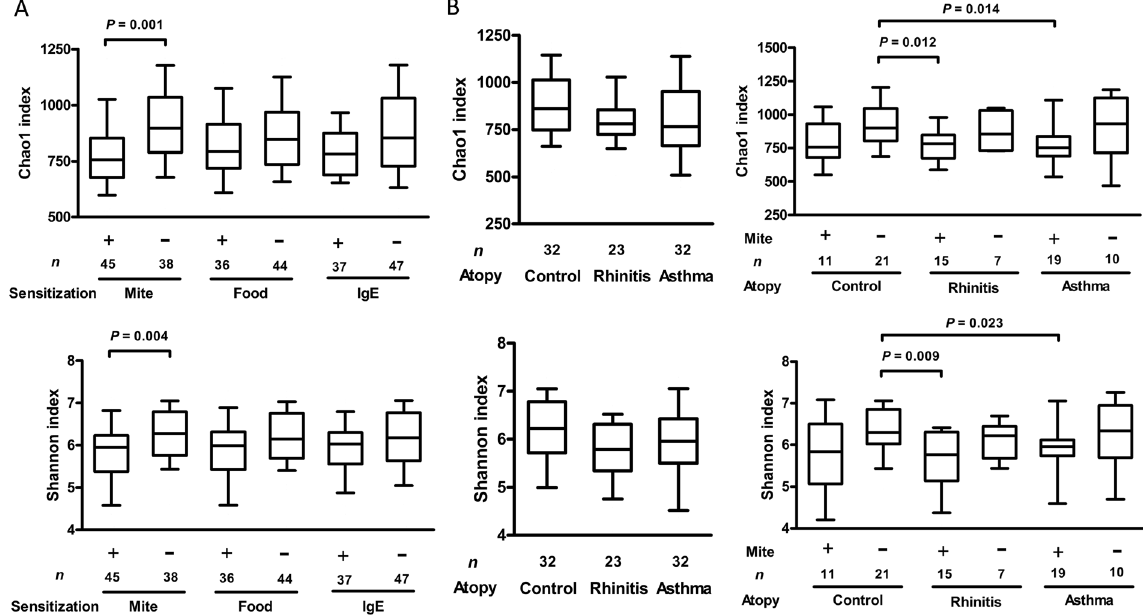
Figure 2. Estimates of bacterial richness and diversity. ( A ) Differences and comparisons of species richness (Chao1 index) and diversity (Shannon index) for atopic indices including allergen sensitization to mite and food, and IgE sensitization ( ≥ 100 kU/L). ( B ) Differences and comparisons of species richness and diversity among topic diseases, and combined with and without mite sensitization. Species richness calculated as the Chao1 index. Species diversity calculated as the Shannon index. The box-plot shows the median and the 10 th , 25 th , 75 th and 90 th percentile. Only significant P values obtained by the Mann-Whitney test are shown.